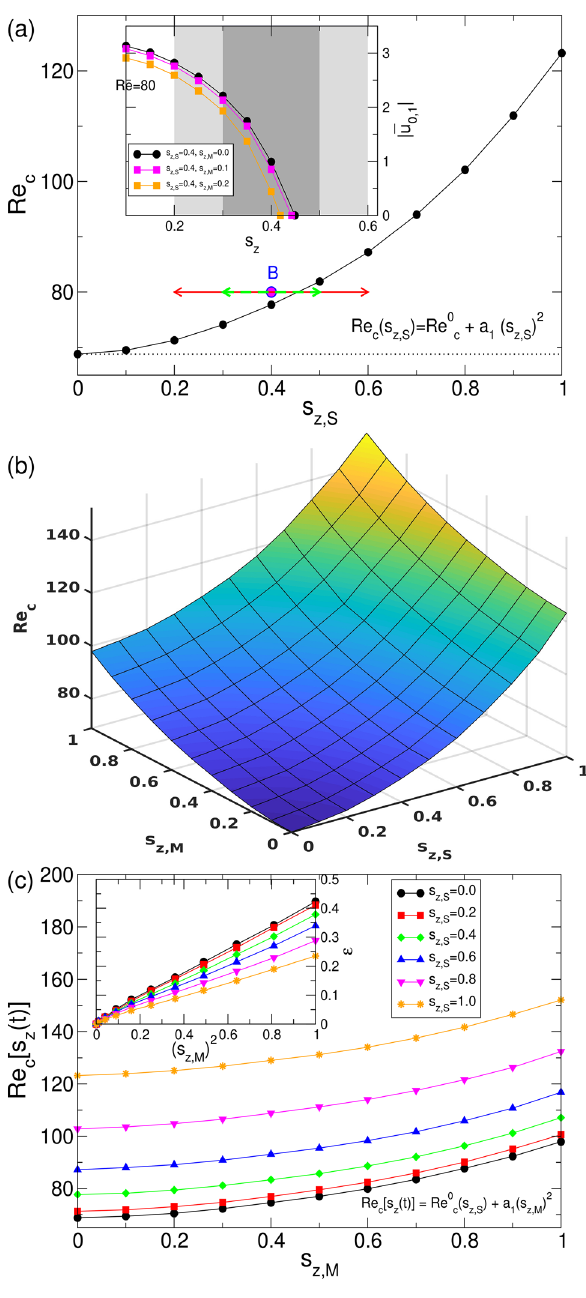
Figure 2. Stability in magnetic fields. ( a ) Stability boundaries for a static magnetic field as a function of s z , S . The curve can be approximated by the function Re c ( s z , S ) = Re 0 c + a 1 s 2 z , S ( a 1 = 53.3 ), where Re 0 c is the stability threshold in absence of any magnetic field. Horizontal arrows at Re = 80 across the stability boundary indicate the range of the alternating magnetic field discussed in Fig. 5. The inset illustrates the bifurcation scenario of the dominant mode amplitude | u 0,1 | for static, and two different modulated driven magnetic fields at parameters as indicated ( (cid:31) H = 100 ) at Re = 80 . ( b ) Surface illustrating the critical Reynolds number Re c over ( s z , S , s z , M ) -plane. ( c ) Cross sections of ( b ) for different static field strength s z , S as indicated. The location of the bifurcation thresholds moves towards larger critical Reynolds number Re c [ s z ( t ) ] (in high frequency limit). The inset shows the relative distance ǫ from the respective onset for static fields versus the squared modulation amplitudes ( s z , M ) 2